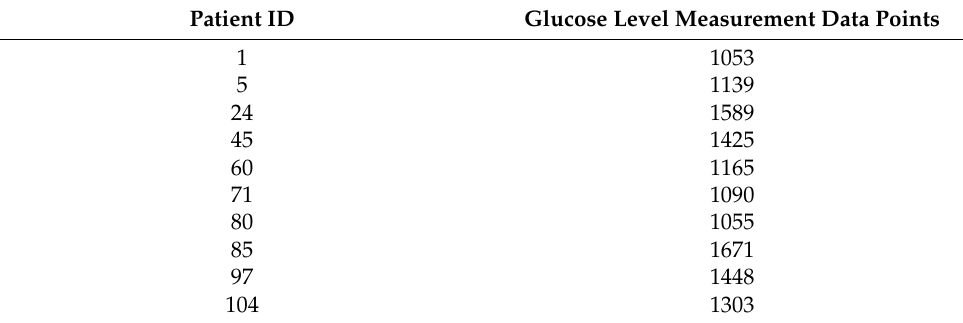
Table 2. The information of the 10 randomly selected patients.